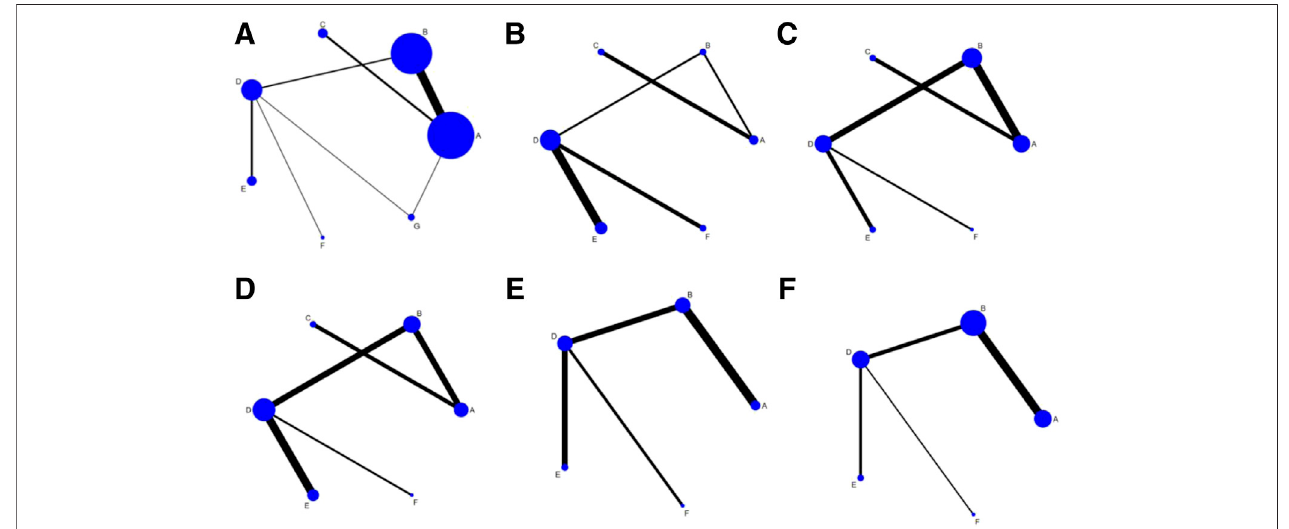
FIGURE 2 | Network diagrams of outcome indicators. (A) effectiveness rate; (B) CK; (C) CK-MB; (D) LDH; (E) cTnI; (F) adverse reaction rate. A: conventional treatment; B: conventional treatment + trimetazidine + Astragalus injection; C: conventional treatment + trimetazidine + Shenfu injection; D: conventional treatment +